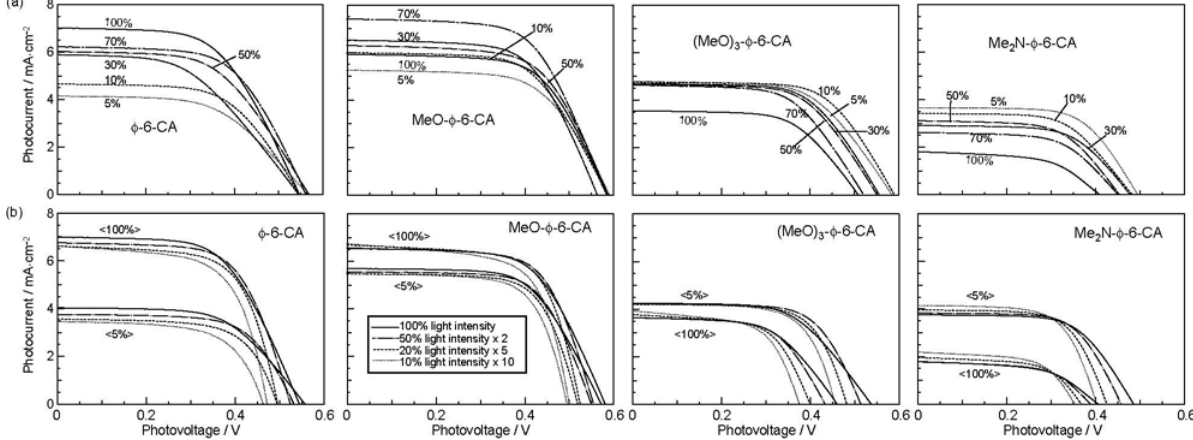
Figure 16. (a) The concentration dependence and (b) the light-intensity dependence (at two different concentrations) of the I–V curves in solar cells using the four sensitizers having different polarizabilities (reprinted from [15], Copyright (2006), with permission from